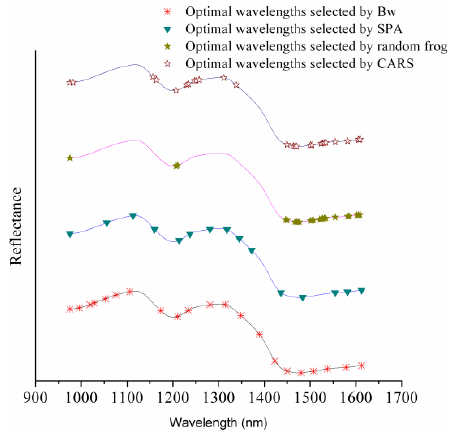
Figure 2. Prediction results of ( a ) the calibration set and ( b ) the prediction set of the PLSR model using the full spectrum.